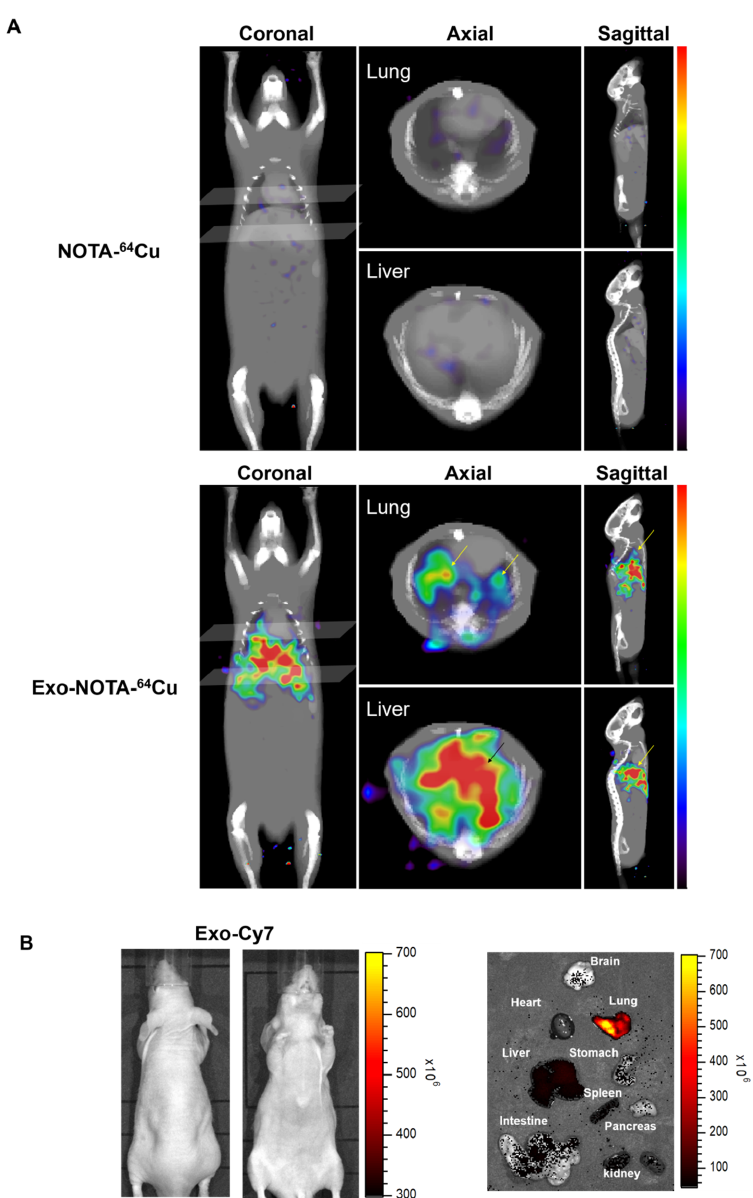
was higher within exosome-injected versus untreated mice, with di ff ering patterns in the PET imaging data (Figure 6C). Int. J. Mol. Sci. 2020 , 21 , x FOR PEER REVIEW